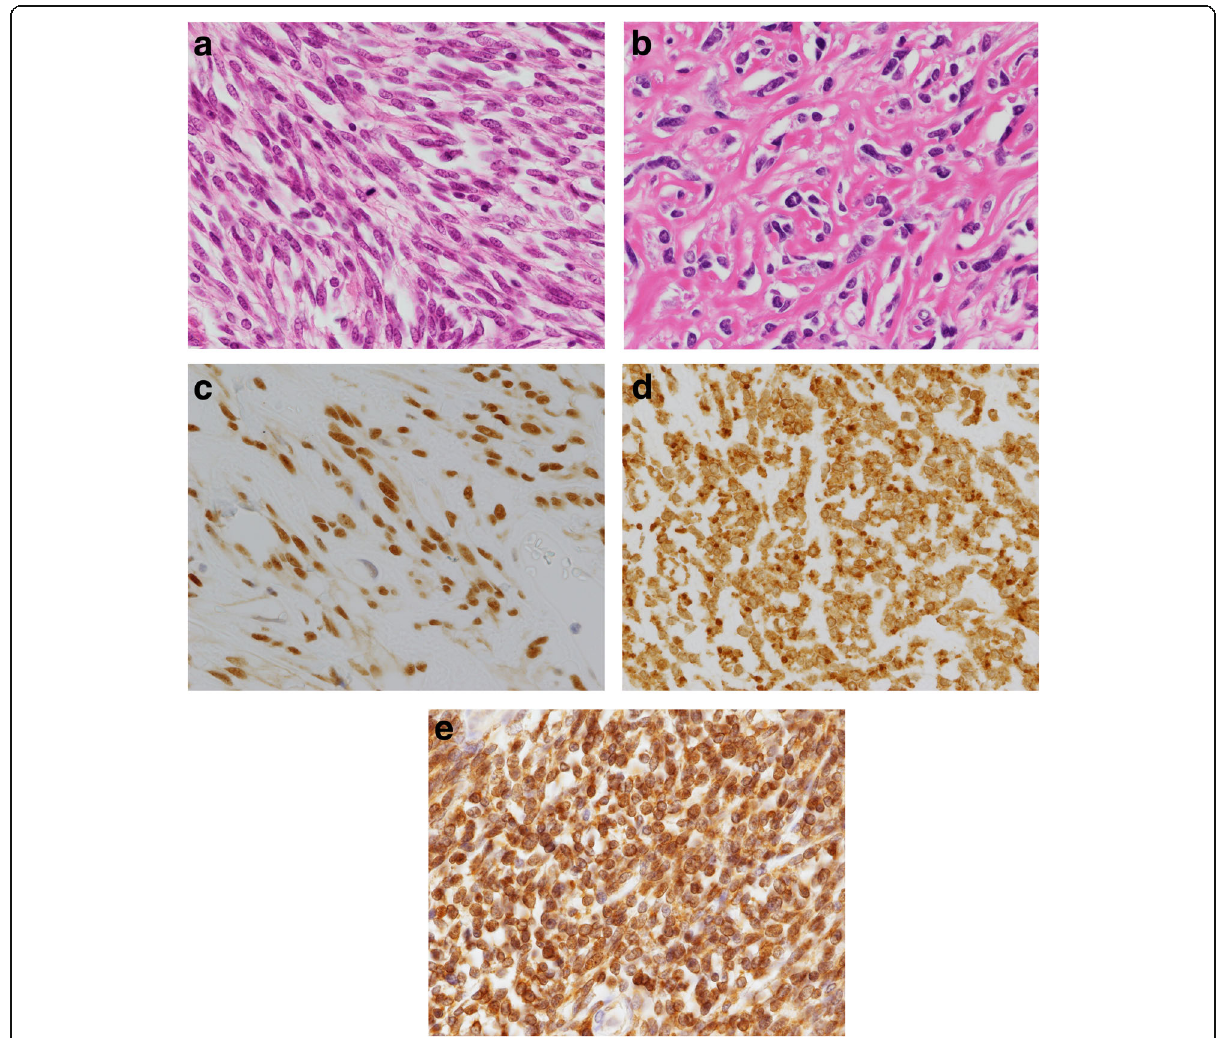
Fig. 4 Histology and immunohistochemistry of the malignant solitary fibrous tumor (SFT). Atypical spindle cells proliferated in the major hypercellular area ( a ). The tumor showed typical SFT-like features with ovoid nuclei and a thick collagenous stroma ( b ). Tumor cells demonstrated immunoreactivity for STAT6, a hallmark of SFT ( c ). The tumor expressed IGF2. Characteristic dot-like reactivity corresponding to the Golgi complex was apparent ( d ). The tumor also showed immunoreactivity for IGF2R ( e